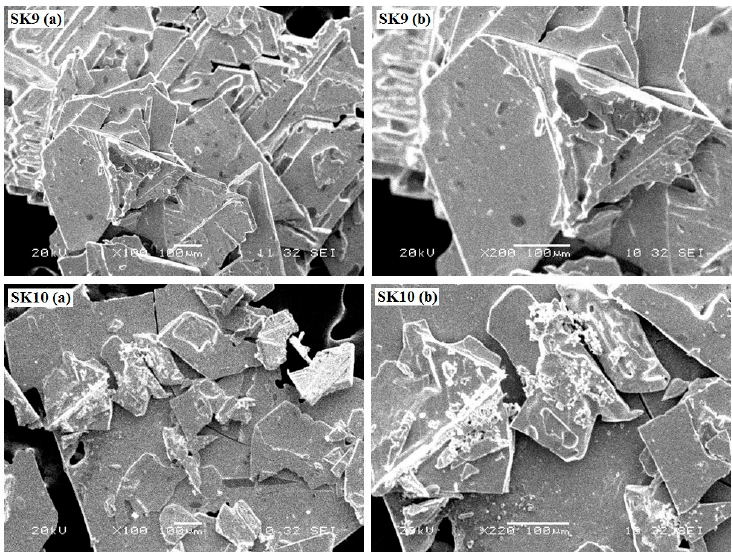
Figure 2. SEM images of synthesized perovskites SK9-SK10 ; [ SK9 ( a ): With ×100 Zooming; SK9 ( b ): ×200 Zooming; SK10 ( a ): With ×100 Zooming; SK10 ( b ): ×220 Zooming]